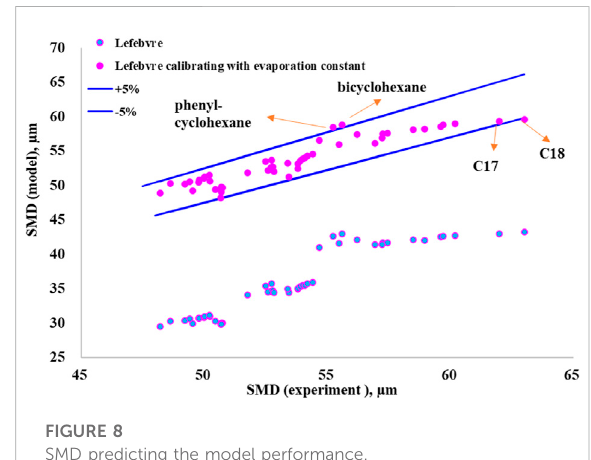
FIGURE 8 SMD predicting the model